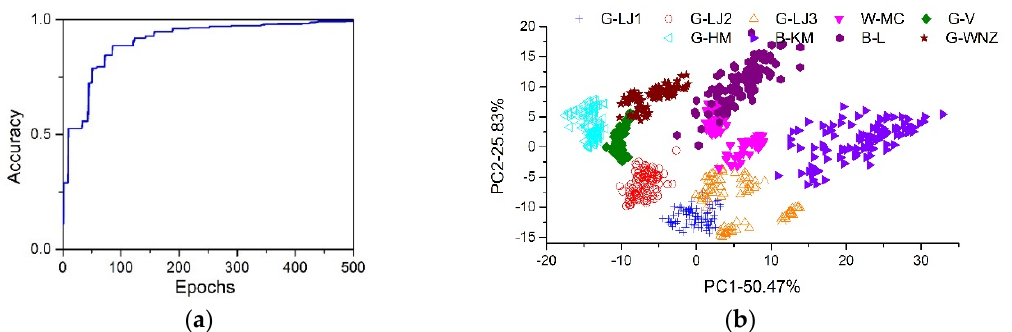
Figure 5. ( a ) CNN prediction accuracy against epochs. ( b ) The PCA score plots (PC1×PC2) based on the outputs of the last but one layer of the CNN.